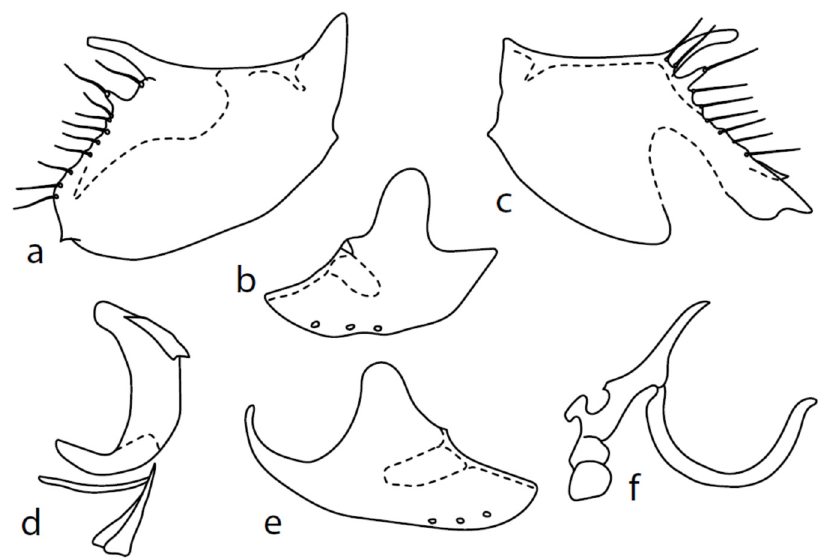
Figure 9. M. intermedius : ( a ) = right epandrial lamella, ( b ) = hypandrium from left, ( c ) = left epandrial lamella, ( d ) = postgonite from left, ( e ) = hypandrium from right, ( f ) = phallus from left. Microphor rostellatus Loew, 1864 Figure 10.